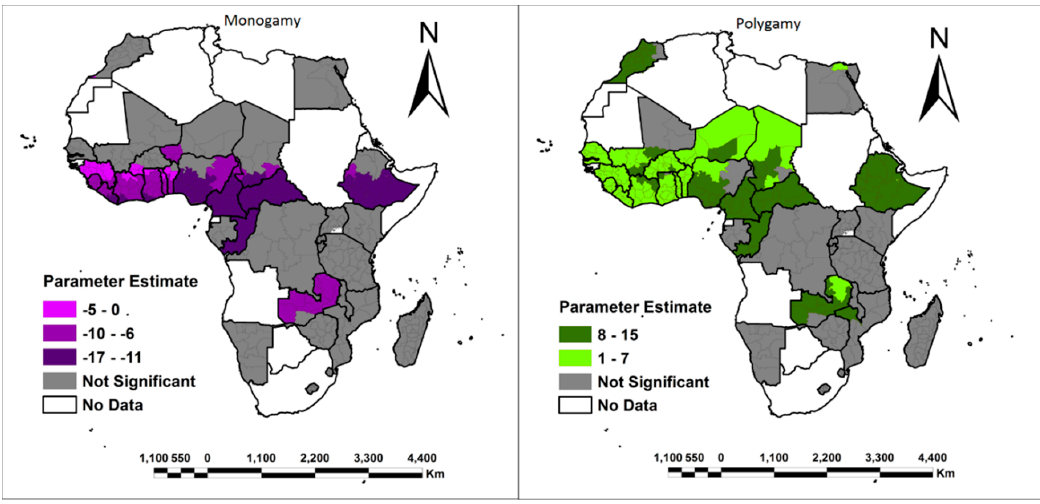
Figure 12. Spatial distribution and significance of monogamous/polygamous relationships on women’s access to family land.